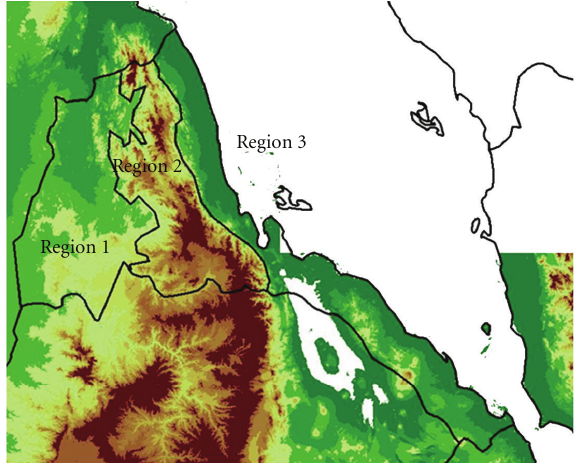
Figure 3: Eritrea map showing the topography of the country with three regions: Region 1 is characterized by low land with high malaria incidence (peak in October), Region 2 is characterized by a mountain area with low malaria incidence (peak in October), and Region 3 is characterized by low land area in the Red Sea coast with low malaria incidence values (peak in January).